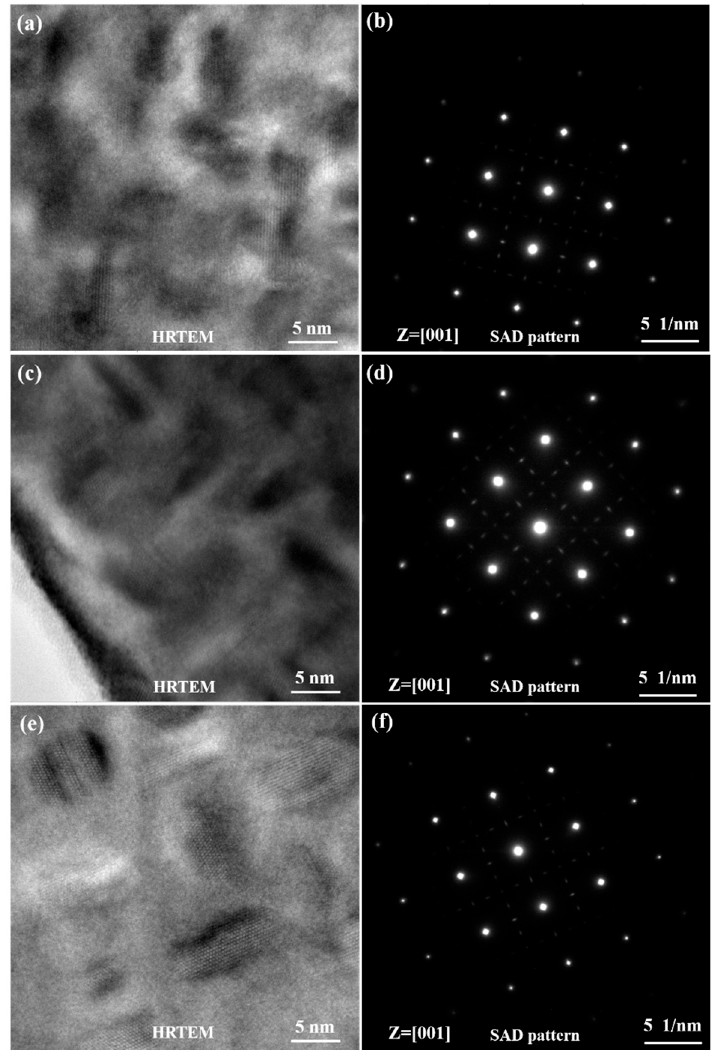
Figure 7. HRTEM images and SAD patterns of γ″ phases. ( a , b ) Specimen B; ( c , d ) specimen C; ( e , f ) specimen D.